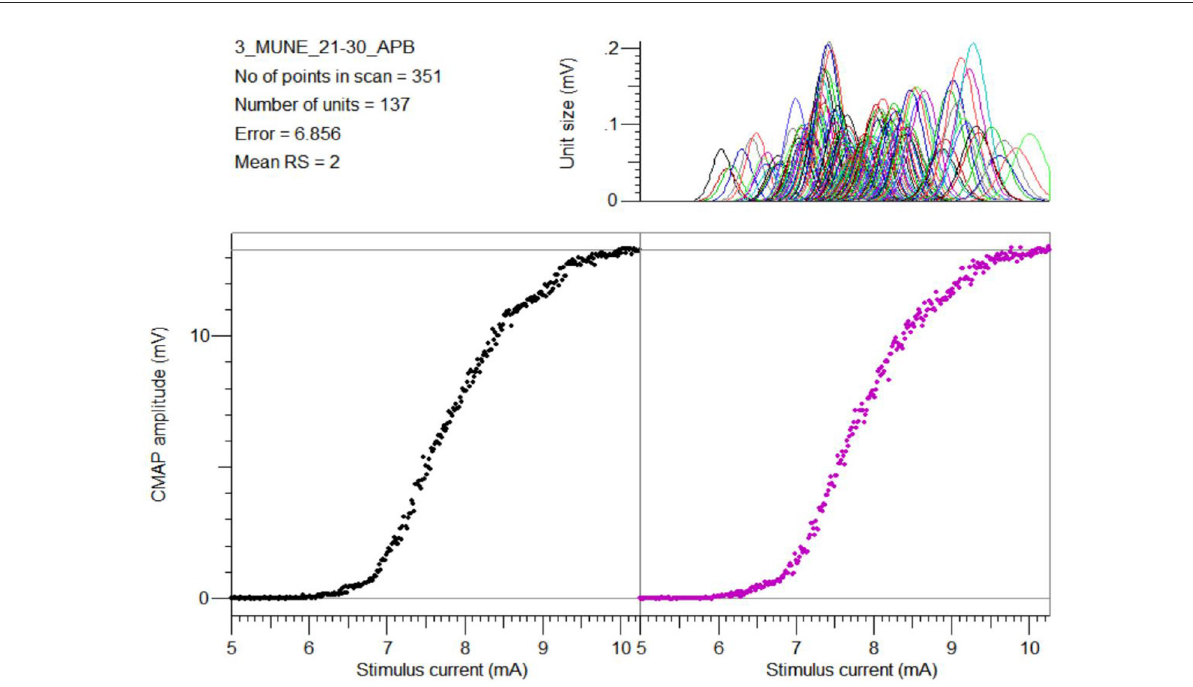
FIGURE2 An example of the experimental CMAP scan from the APB muscle (bottom left) , the modeled CMAP scan using the MScanFit program (bottom right) , and the estimated motor unit action potential distribution (top right)